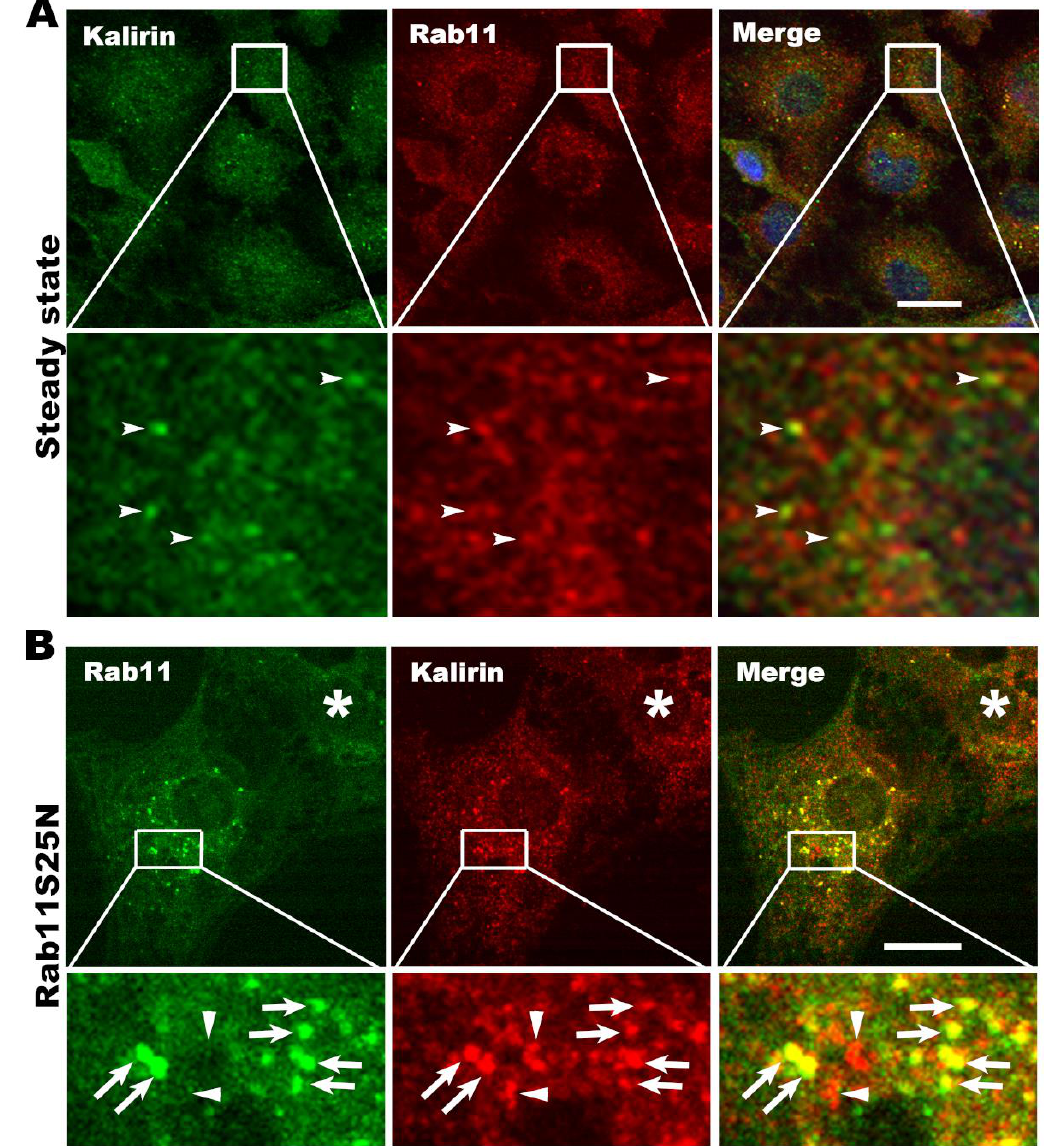
Figure 4. Kalirin locates at Rab11 positive recycling endosomes. ( A ) Low frequency of co-localization between kalirin and Rab11 at steady state. NRK cells on glass coverslips were fixed and processed for labeling with antibodies for kalirin (green) and Rab11 (red). Shown are confocal images. Boxed regions are enlarged and shown underneath the corresponding image / channel. Arrowheads identify structures co-labeled with Rab11 and kalirin. Scale bar: 10 µ m. ( B ) Enhanced co-localization of kalirin with Rab11 upon expression of Rab11S25N, a dominant negative mutant of Rab11. NRK cells on glass coverslips seeded in a 6-well plate were transfected with 0.3 µ g of pcDNA 3 -Rab11S25N. After 5 h of culture, cells were processed for labeling Rab11 (green) and kalirin (red). Boxed regions are enlarged and shown underneath the corresponding image / channel. Arrows indicate structures containing both Rab11 and kalirin, whereas arrowheads identify Rab11 positive structures void of kalirin. The star symbol in each channel indicates a cell likely to be not transfected. Scale bar: 5 m.